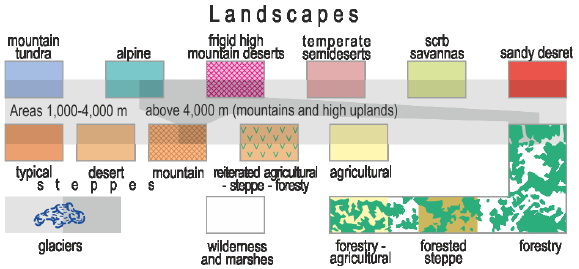
Fig. 5. An example of a legend of landscape maps by F. Uhorczak with marked altitude zones (the authors’ elaboration based on the map of South-East Asia from volume V of “Universal